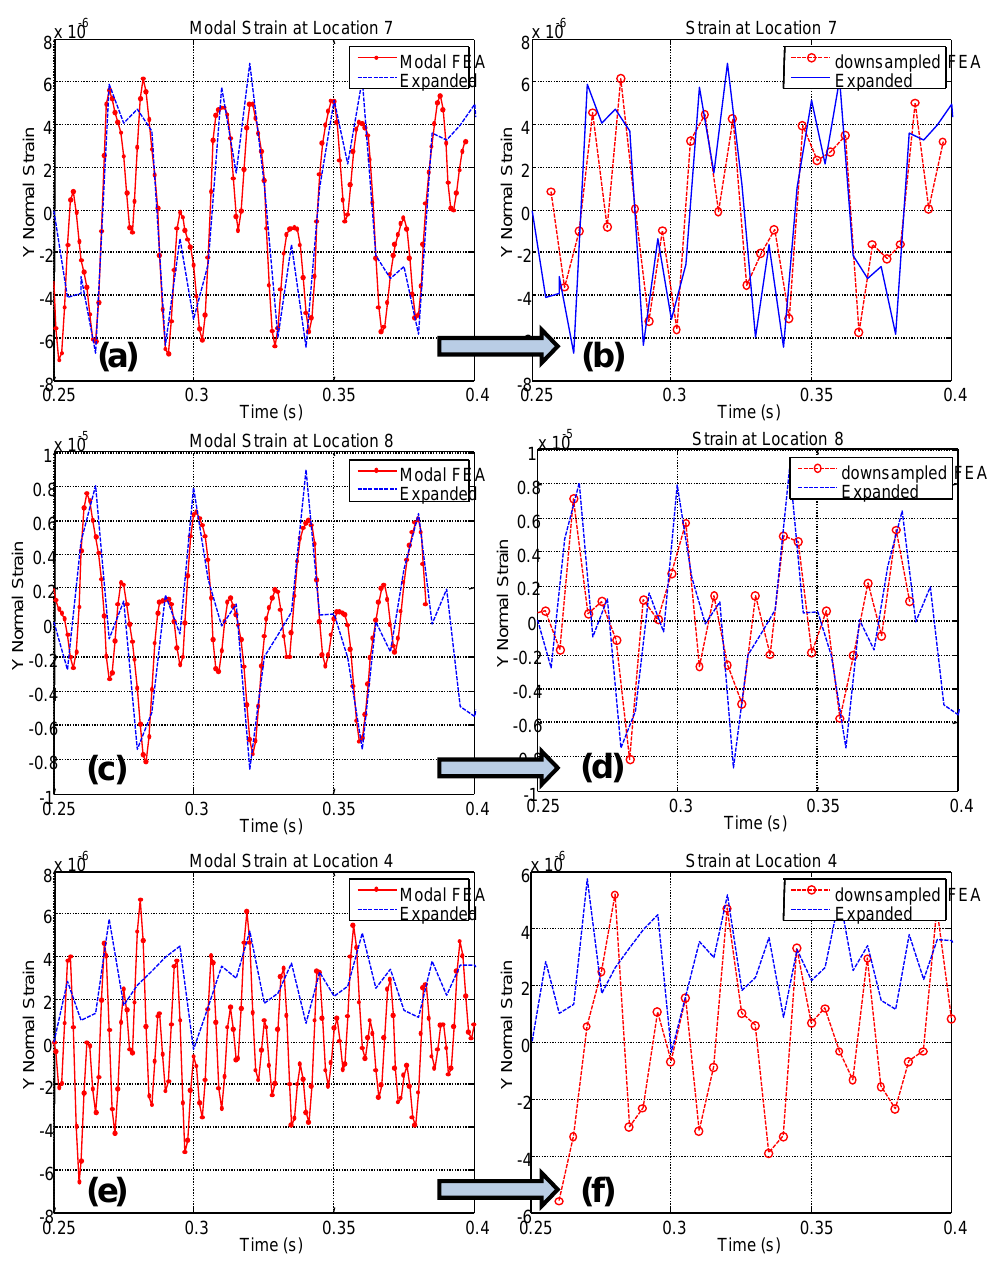
Fig. 17. Comparison of strain response from FEA solution and predicted solution using a mode superposition approach with (a, c, e) contain finer step and (b, d, f) contain identical time proposed technique. The FEA solution was performed at a finer time step to properly obtain an accurate numerical solution. This implies that the FEA and test data have different time increments. The FEA strain response had to be decimated (or down-sampled) to the response data points recorded during experimentation. The comparison of this decimated FEA strain solution with the predicted strain response using the expansion technique is shown in Figs 16b, d and f for locations 7, 8 and 4 respectively.